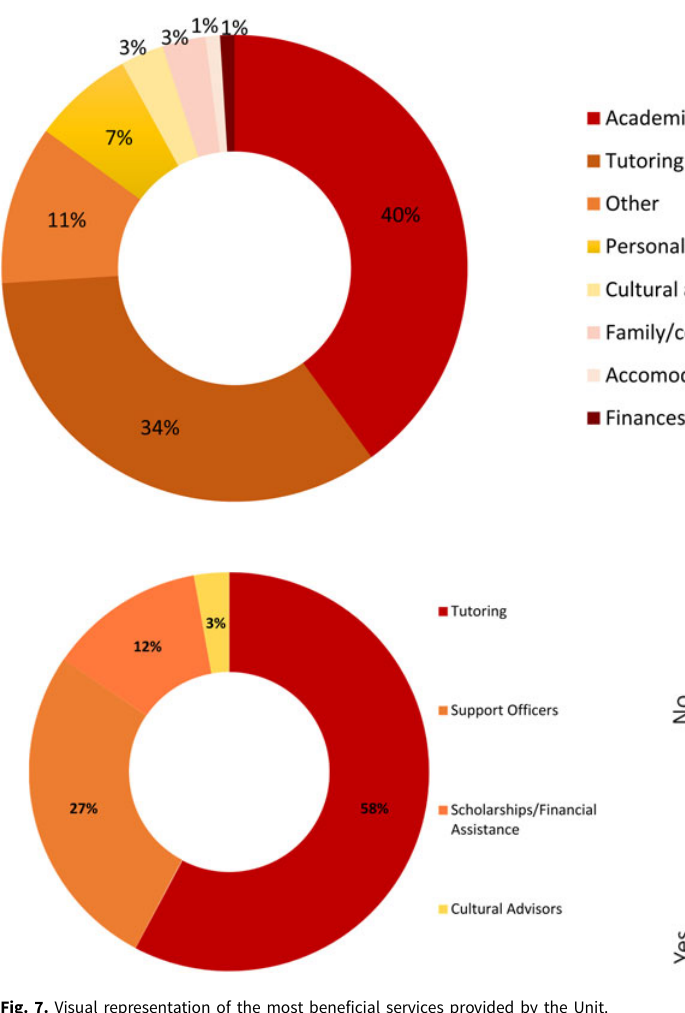
Fig. 7. Visual representation of the most beneficial services provided by the Unit.